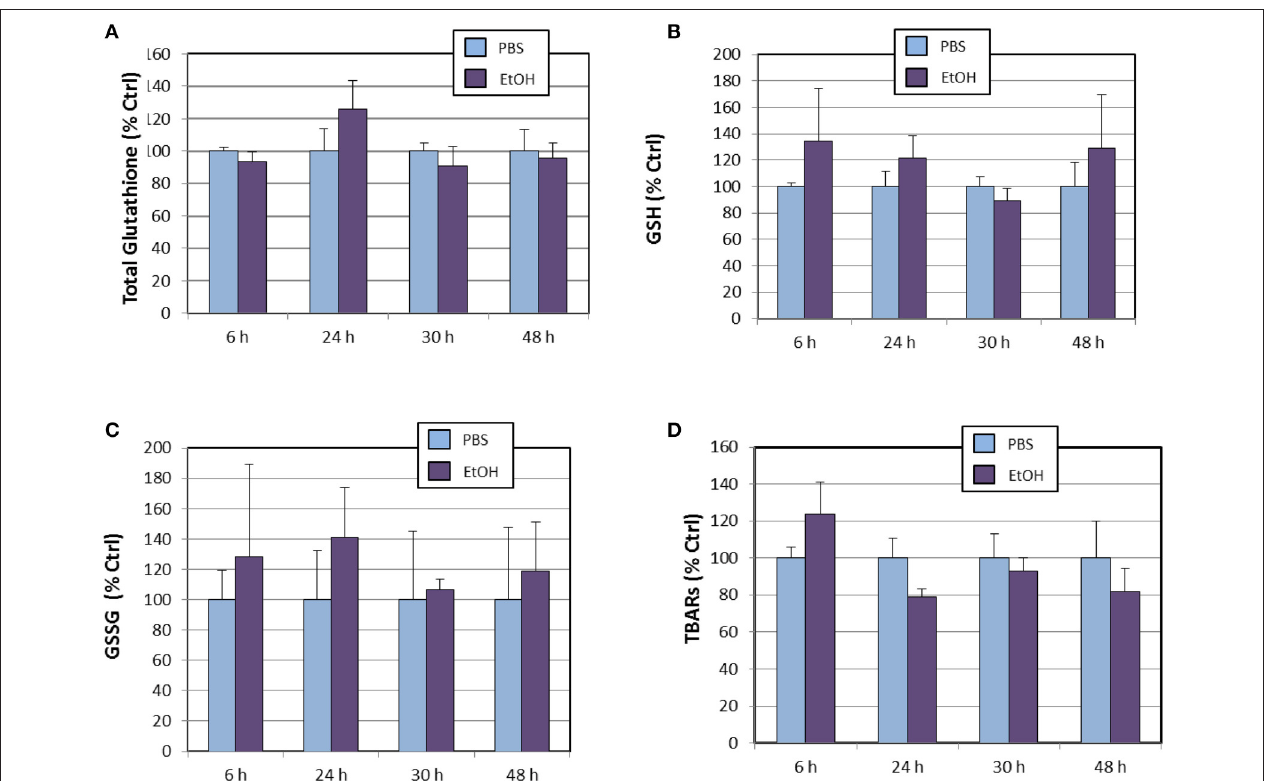
FIGURE 4 | Effects of ethanol (EtOH, 0.1%) on total glutathione (A), reduced glutathione (B), oxidized glutathione (C), and TBARs (D) levels in HT22 cells at different times after first exposure to ethanol. Results correspond to the mean ± SEM of four different experiments.